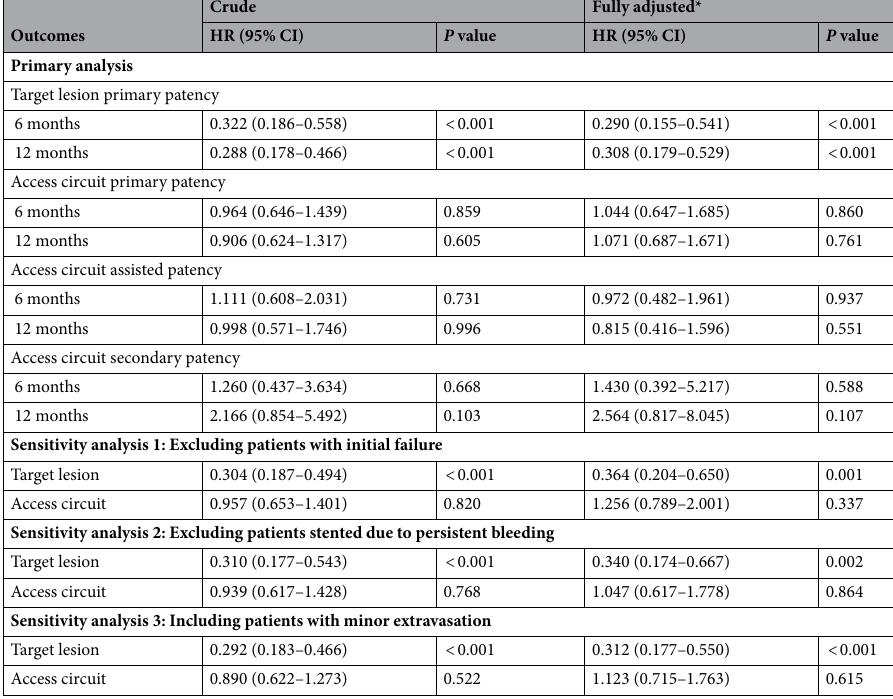
Table 3. Cox proportional hazard ratio of patency: patients with rupture dialysis access undergoing stent graft in comparison with balloon tamponade. Primary analyses: 6-month and 12-month target lesion and access circuit primary patency, access circuit assisted patency, and access circuit secondary patency; Sensitivity analyses: 12-month target lesion and access circuit primary patency. CI confidence interval, HR hazard ratio. *Adjusted by age, sex, hypertension, diabetes mellitus, coronary artery disease, smoking, dyslipidemia, shunt age, native, left/right, forearm/upper, total occlusion, multiple lesions, rupture flow, percutaneous thrombectomy device, cutting balloon, balloon diameter, balloon